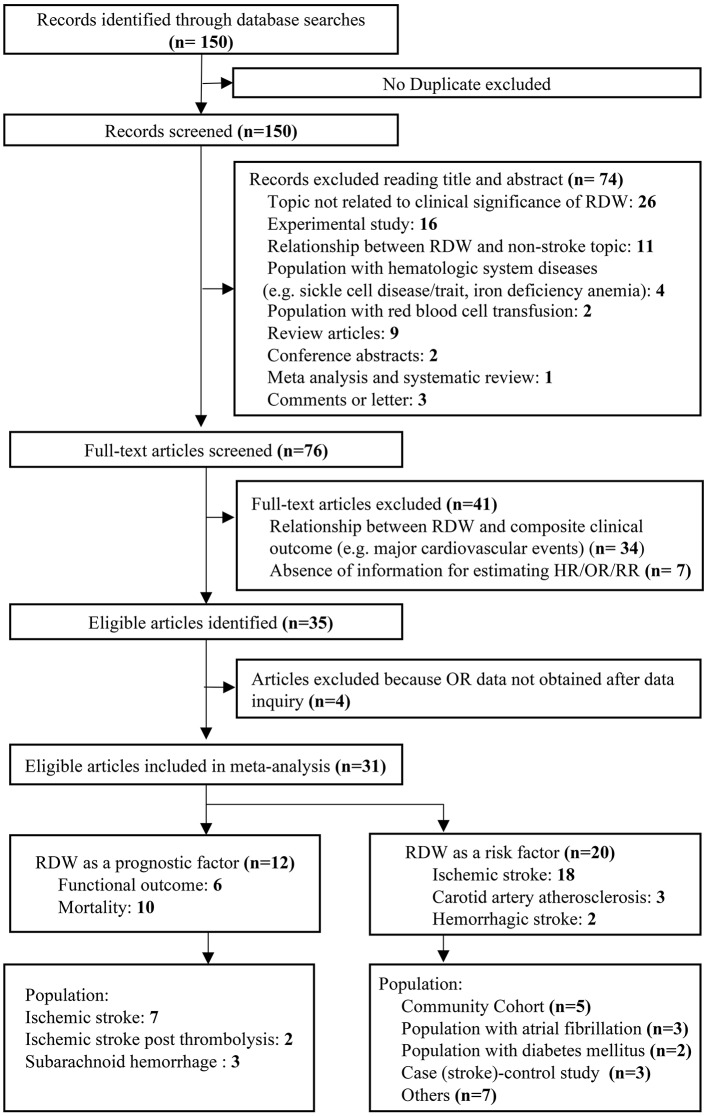
Flow diagram of the study selection process.